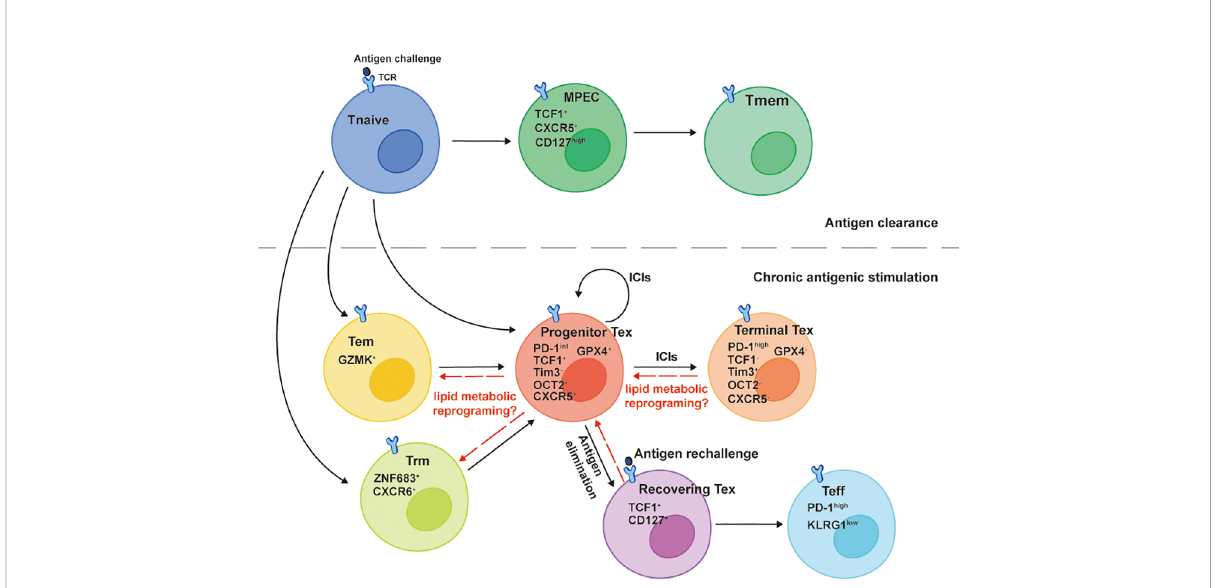
FIGURE 2 Developmental trajectories of Tex cells. The TCF1 + Tim-3 - progenitor Tex cells denote a cluster of Tex cells with self-renew ability that differentiate into TCF1 - Tim-3 + Terminal Tex cells when responding to ICIs, such as PD-1 inhibitors. TCF1 and newly identi fi ed OCT2 are signature molecules for the progenitor Tex cells memory-like plasticity. They emerge and develop from either GZMK + Tem cells or ZNF683 + CXCR6 + Trm cells in the chronic antigenic stimulation circumstance and share memory-like features with TCF1 + CXCR5 + CD127 high MPECs that give rise to Tmem cells after the antigen clearance. The TCF1 - Tim-3 + terminal Tex cells lose lipid metabolic plasticity along with the downregulation of GPX4. Though they derive a fraction of recovering Tex cells reacquiring TCF1 and CD127 expressions after chronic antigen elimination, the PD-1 high KLRG1 low Teff cells generated from the recovering Tex cells can ’ t ef fi ciently eliminate a secondary antigen challenge because of the defect